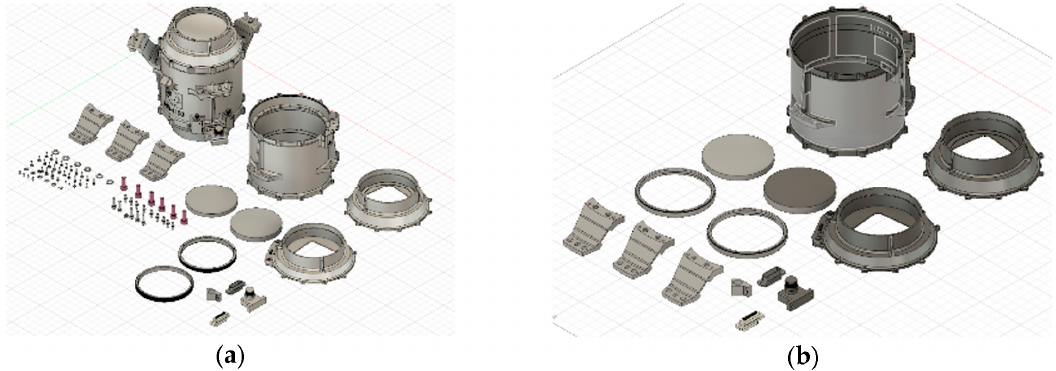
Figure 5. ( a ) Original subassembly 8 (82 pieces). ( b ) Subassembly 8 prepared for manufacturing (14 pieces).